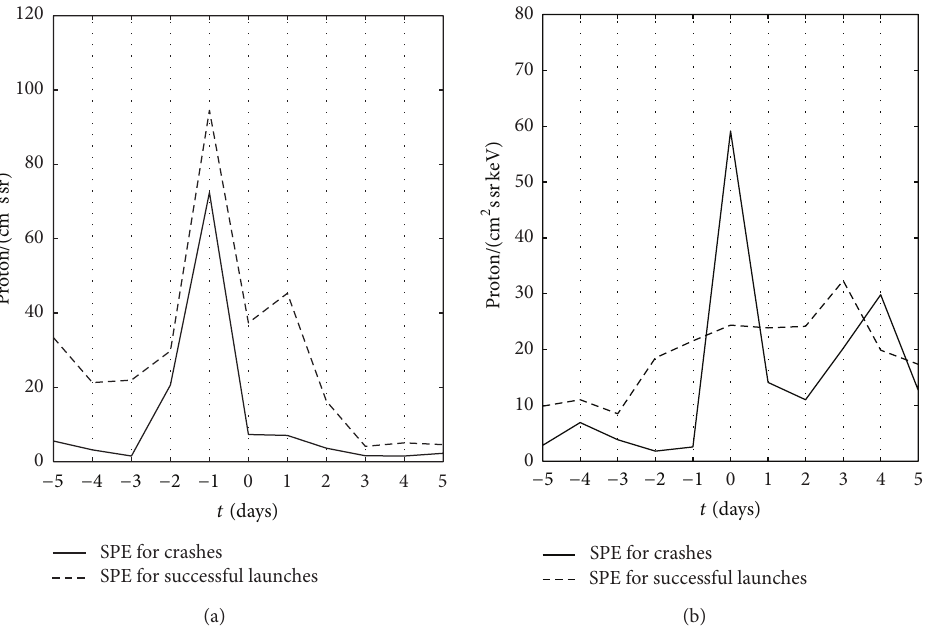
Figure 15: The proton flux rate with 𝐸 > 4 MeV averaged over crash events in the 5 days interval around the moment of launch: (a) Cape Canaveral; (b)